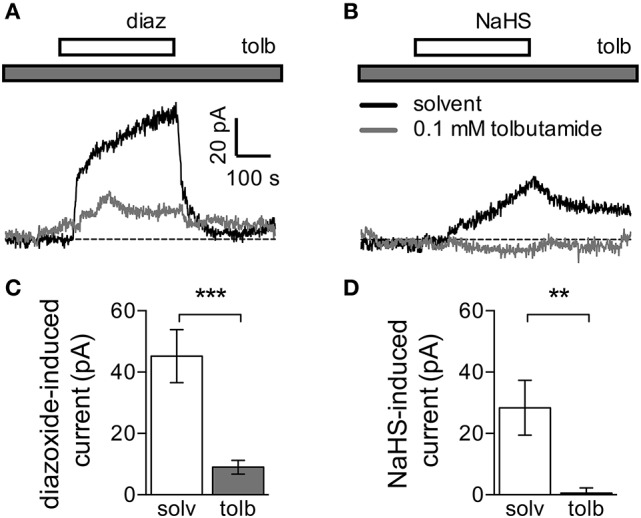
Currents induced by NaHS and the KATP channel activator diazoxide. Currents were recorded in the perforated voltage-clamp mode at voltages corresponding to the resting membrane potential. The latter was determined in current-clamp mode, and then the cells were voltage-clamped at the respective value. NaHS (0.3 mM) or diazoxide (0.3 mM) were applied for periods of 300 s, in the continuous presence of either solvent (0.5% DMSO + 0.5% NaOH) or tolbutamide (0.1 mM). Panels (A,B) show original traces of currents induced by either (A) diazoxide (diaz) or (B) NaHS in the continuous presence of either solvent (black trace) or tolbutamide (tolb, gray trace). Solvent and tolbutamide were preapplied 120 s before the start of diazoxide or NaHS, respectively. (C,D) Amplitudes of currents induced by (C) diazoxide (n = 8) or (D) NaHS (n = 5) in the presence of solvent (solv) and tolbutamide (tolb), respectively. ** and *** Indicate significant differences between amplitudes at p < 0.01 and p < 0.001, respectively (Mann-Whitney test).